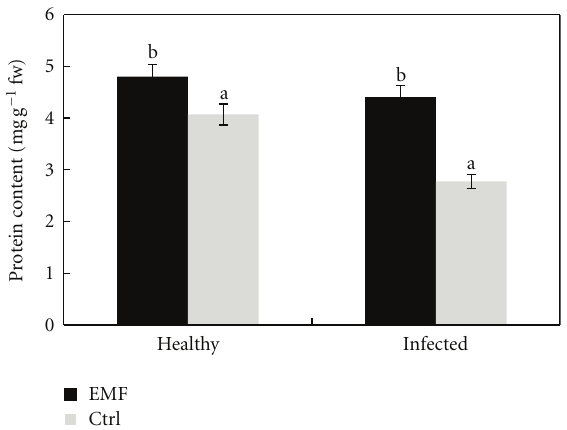
Figure 2: E ff ect of EMF on the protein content in healthy and infected plants of Citrus aurantifolia. Vertical bars indicate mean ± SE of three replicates. Di ff erent letters indicate significant di ff er- ences ( P < 0 . 05).